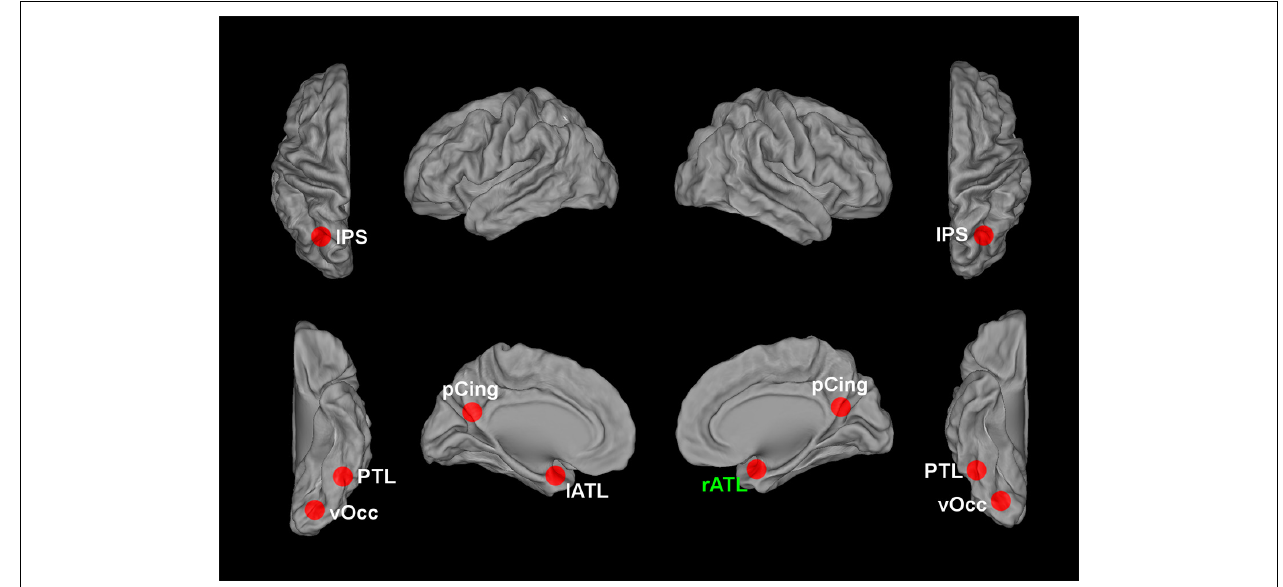
FIGURE 1 | Brain regions encoding information that contributes to the classification between different face tokens corresponding to different individuals. vOcc, ventral occipital cortex; PTL, posterior temporal lobe; ATL,